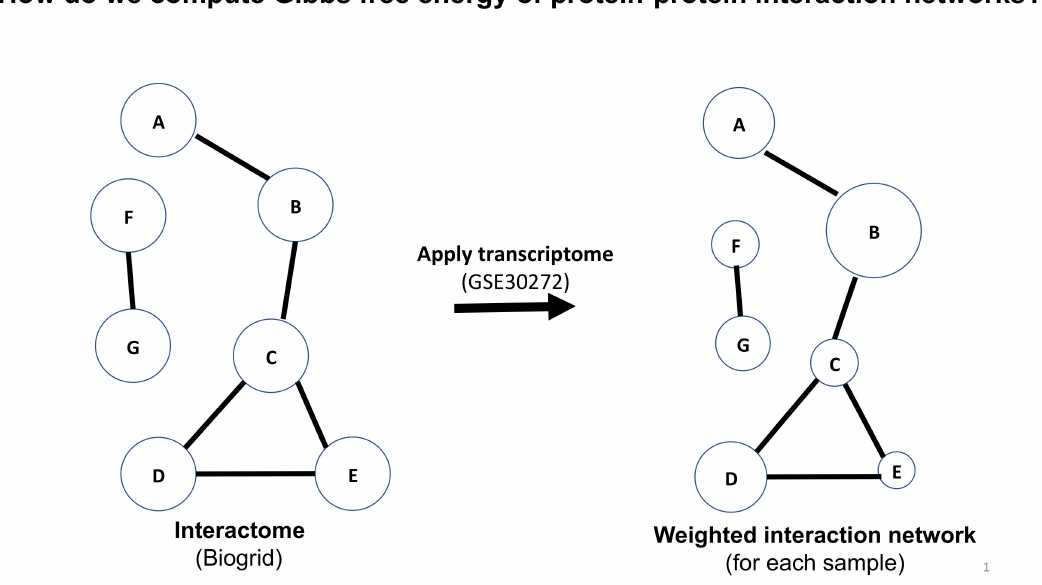
Figure 1. A schematic illustration of the process of computing the Gibbs free energy for a protein–protein interaction